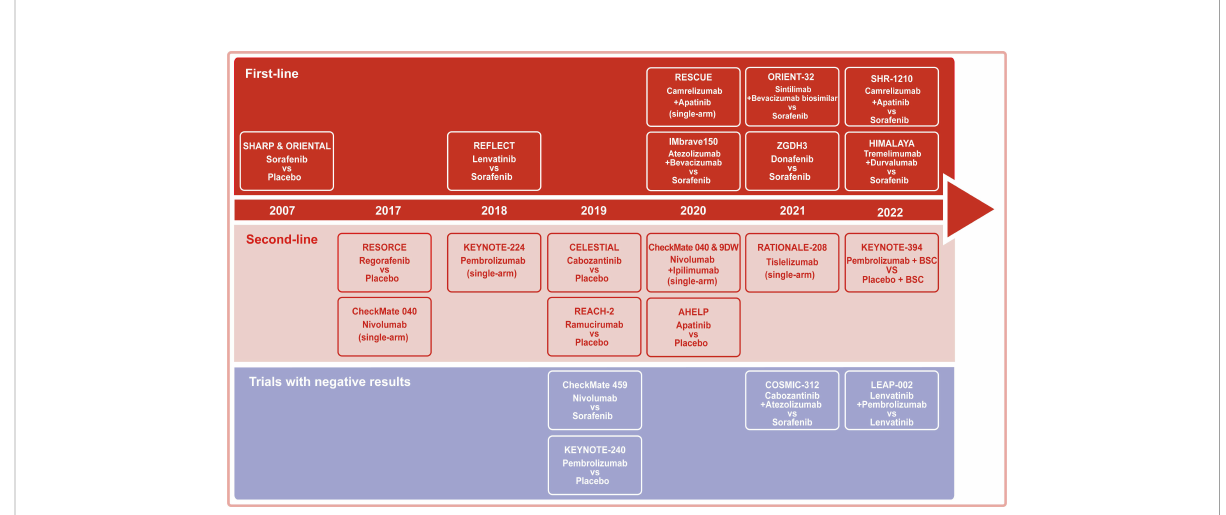
FIGURE 2 Representative clinical trials for the systemic treatment of HCC. Background color: red for trials with fi rst-line settings, pink for trials with second-line settings, and purple for trials with negative